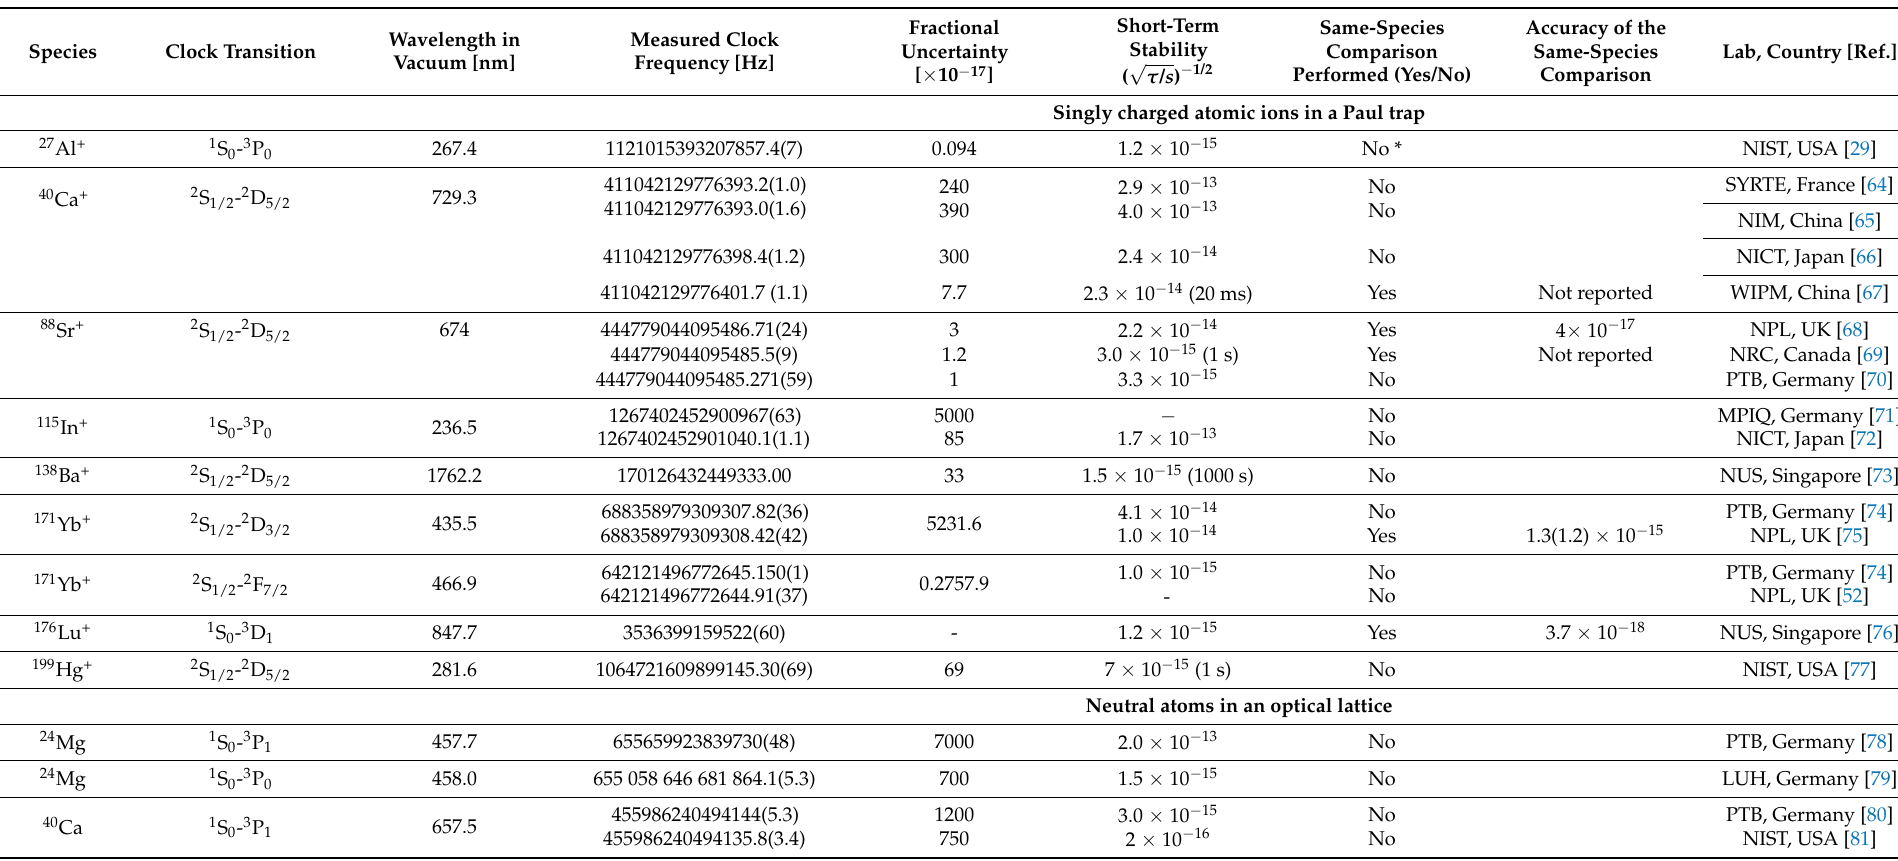
Table 2. A list of species demonstrated as optical frequency standards worldwide is shown with their reported fractional accuracy and frequency